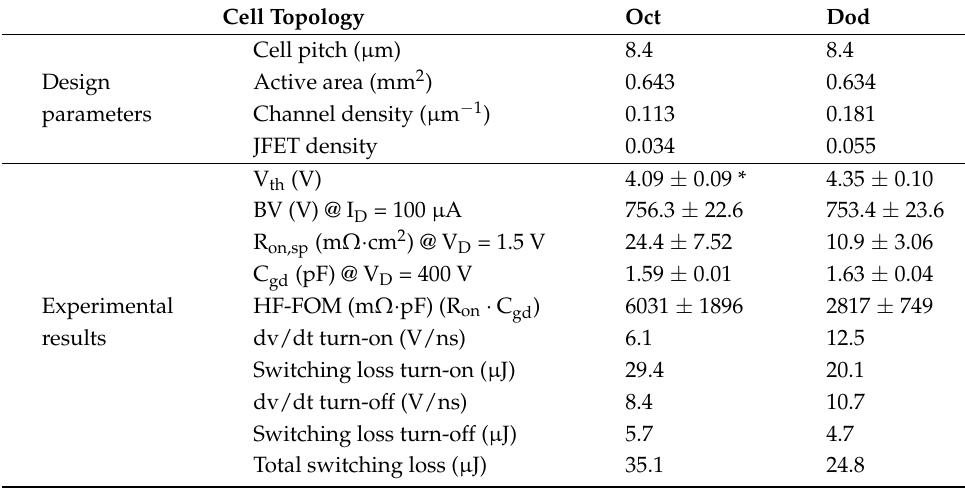
Table 1. Design parameters and experimental